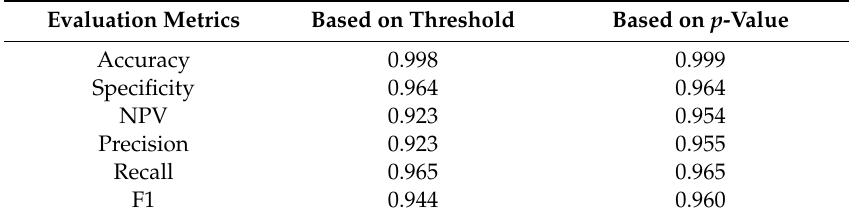
Table 4. Performance result based on